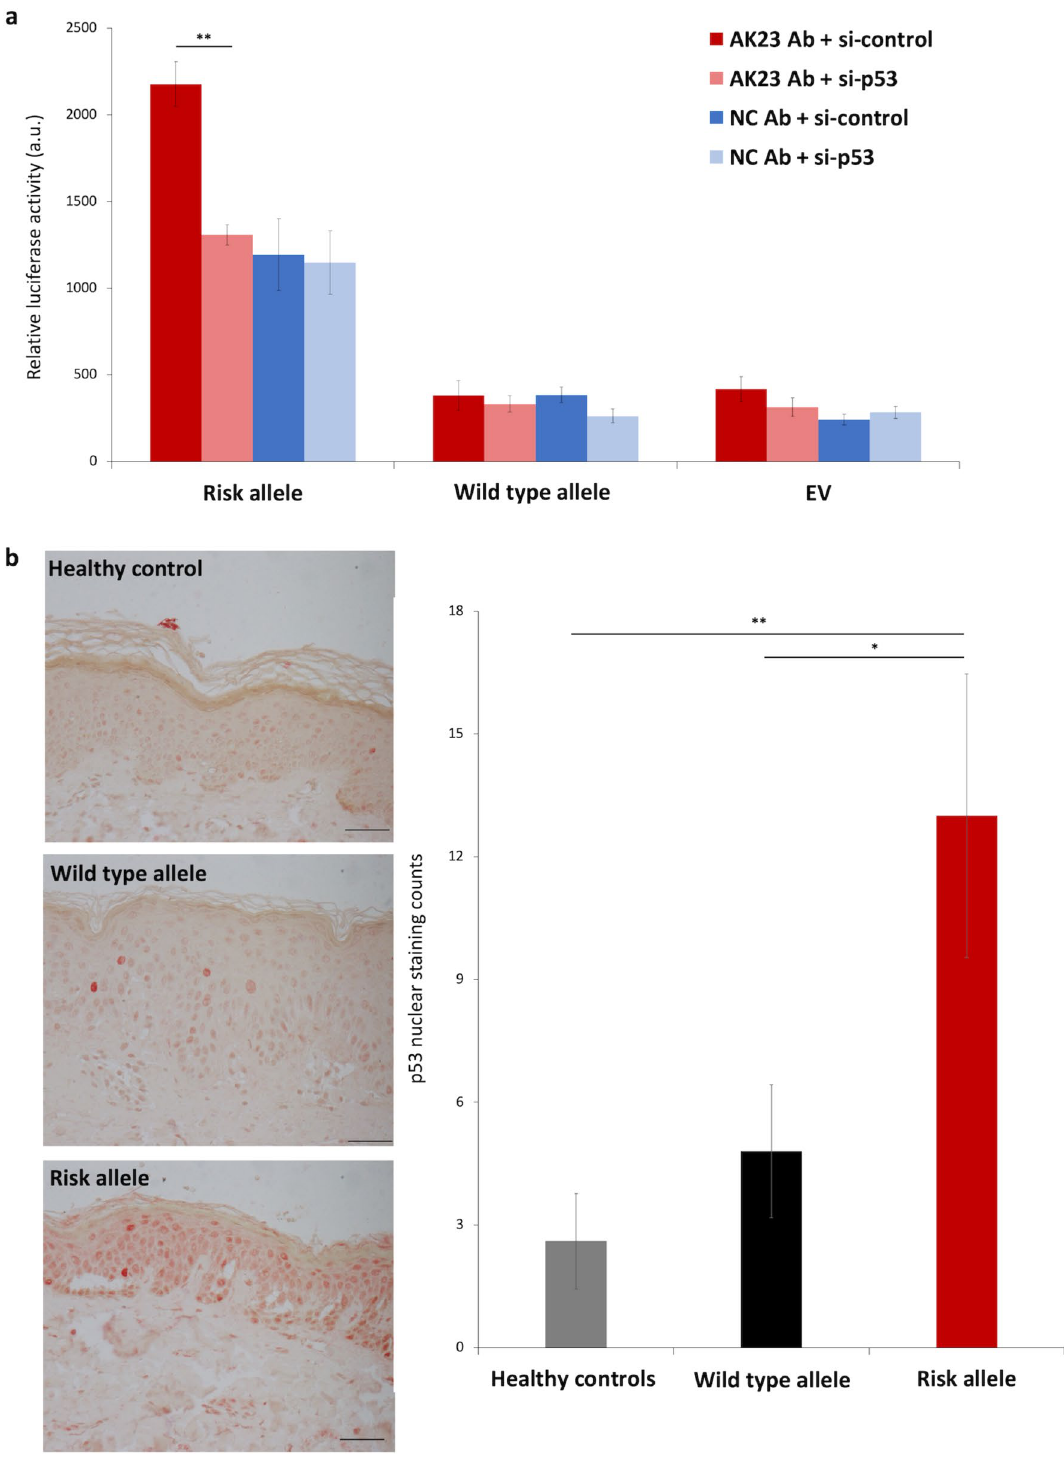
Figure 3. DSG3 down-regulation affects p53-dependent ST18 promoter activity. ( a ) NHEKs were transfected with a an empty vector (EV) as a control or with a luciferase reporter construct under the regulation of a 282 bp ST18 promoter fragment harbouring either the rs17315309 wild type or risk alleles. Cells were additionally transfected with control (si-control) or TP53 -specific siRNAs (si-p53). Twenty four hours post-transfection, cells were treated either with AK23 antibody (AK23 Ab) or negative control antibody (NC Ab). Results represent the mean ± SE of three independent experiments (**p < 0.01 by 2-tailed t test); ( b ) Immunohistochemistry (left panel) of p53 nuclear stain in skin biopsy samples obtained from PV patients carrying rs17315309 wild type (n = 5) or risk alleles (n = 3) or from healthy controls (n = 5) (scale bar = 100um). p53 nuclear staining was quantified (right panel) by two independent evaluators (*p < 0.05, **p < 0.01 by 2-tailed t